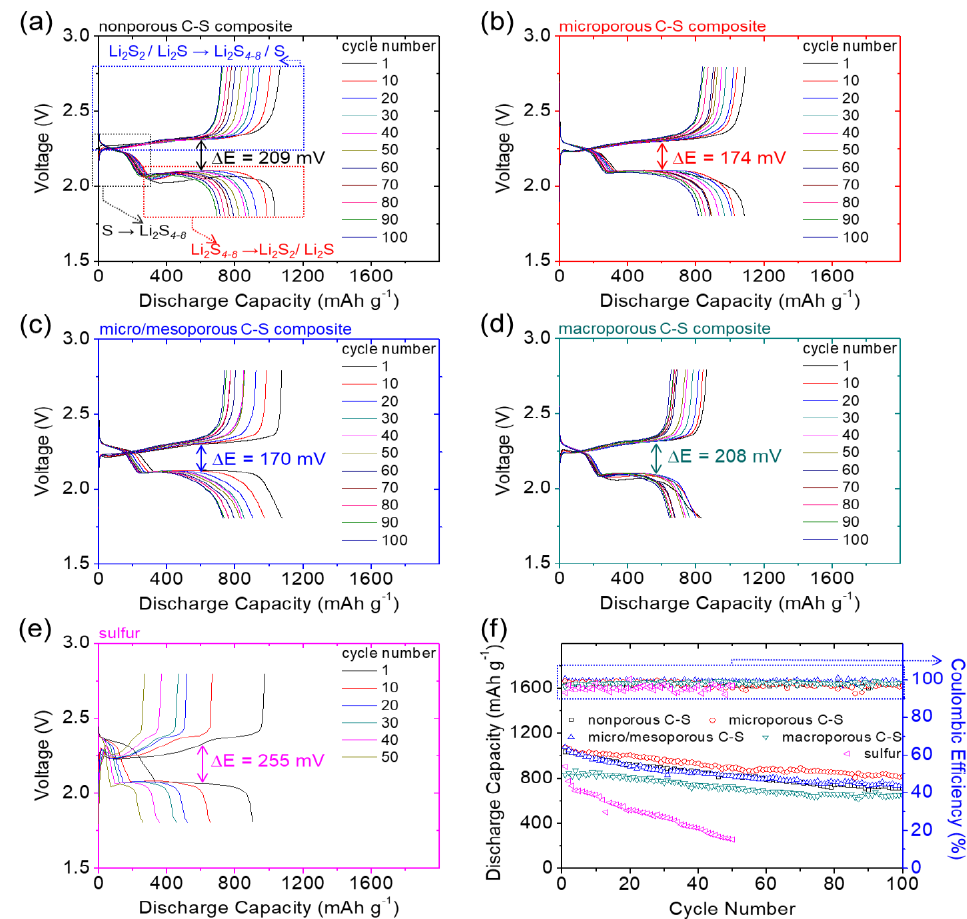
Figure 2. Electrochemical analysis of various carbon–sulfur (C–S) nanocomposites: voltage profiles of ( a ) nonporous C–S, ( b ) microporous C–S, ( c ) micro/mesoporous C–S, ( d ) macroporous C–S, and ( e ) sulfur; ( f ) cyclability.